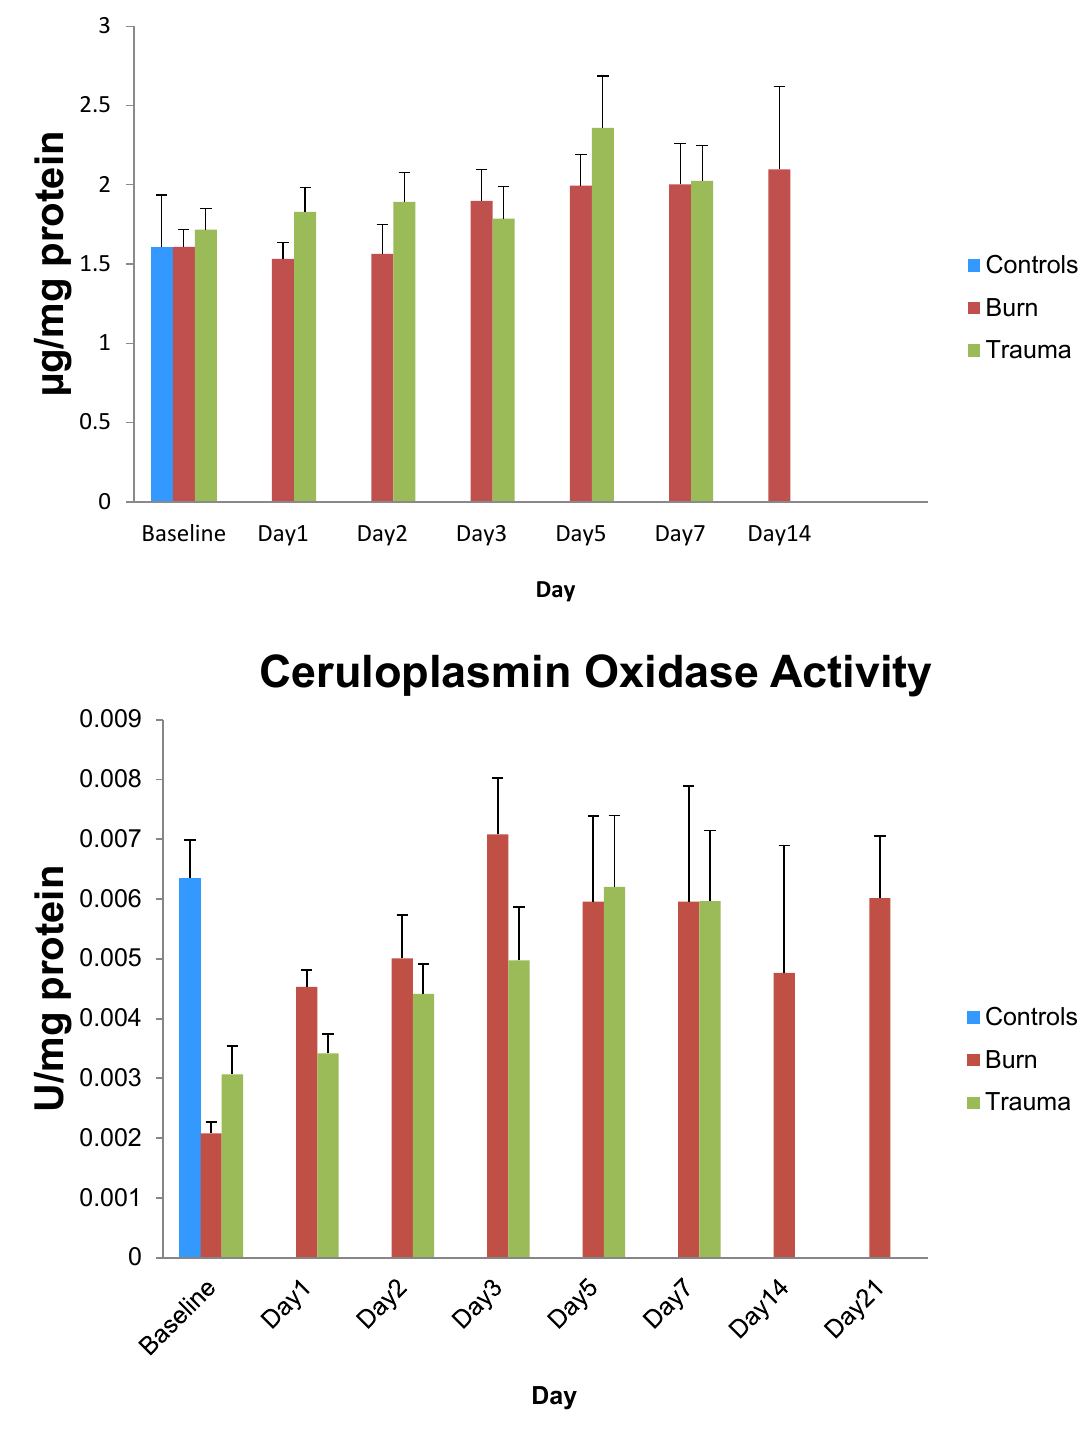
Figure 5. Ceruloplasmin protein concentrations and oxidase activity over 14 days in thermally injured and non-burned trauma patients. Data expressed as mean ± SE from 24 burned and 35 non-burned trauma patients and 10 healthy